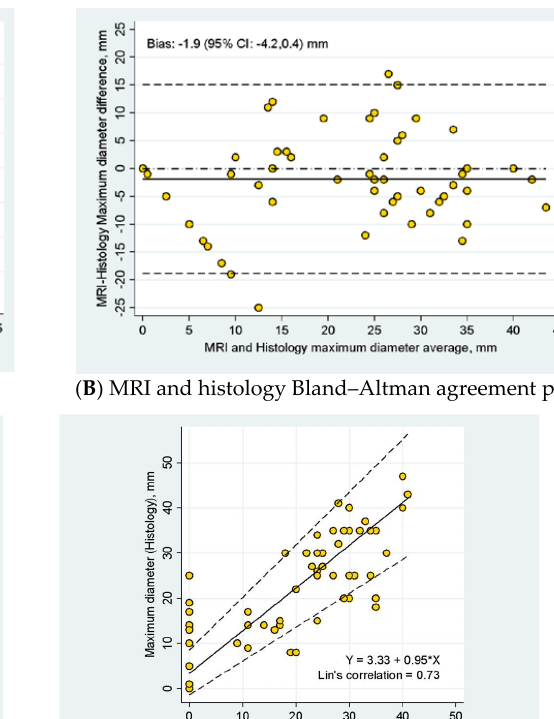
Figure 4. Detection of small tumors with VGS. ( A , B ) Small tumor not detectable at TVUS and MRI; ( C,D ) the same tumor detected by adding VGS and PD.